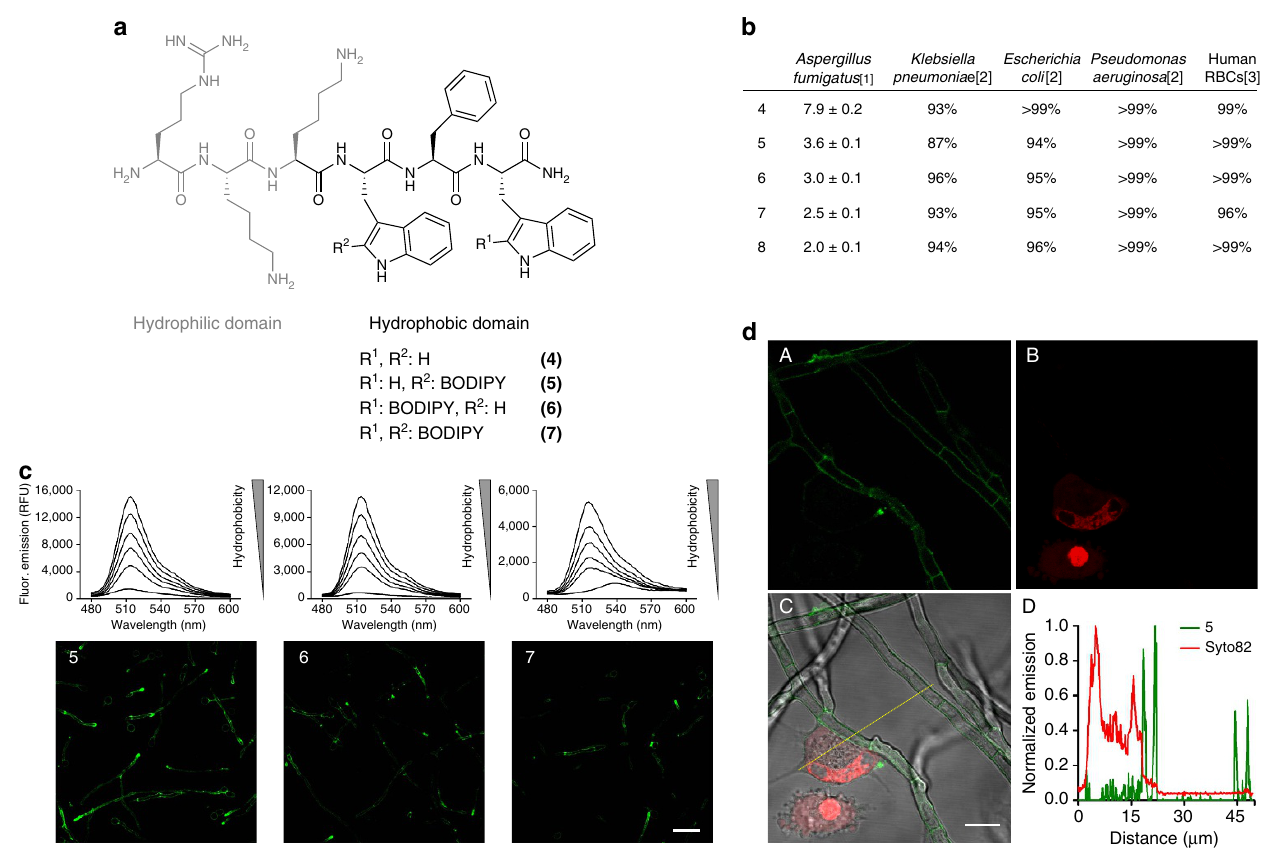
Figure 2 | Fluorogenic peptides for live cell imaging of A.fumigatus in co-culture with human lung epithelial cells. ( a ) Chemical structures of non- labelled and fluorogenic linear peptides ( 4 - 7 ), highlighting the two conserved hydrophilic (grey) and hydrophobic (black) domains of Peptide Antifungal 26 (PAF26). ( b ) Activity of antimicrobial peptides in A. fumigatus , several bacterial strains and in human RBCs.[1] IC 50 ( m M) values represented as means ± s.e.m. from n ¼ 3, [2] cell viability upon 16h incubation with 4 – 8 at their respective IC 50 concentrations ( n ¼ 3), [3] cell viability upon 1h incubation with 4 – 8 at their respective IC 50 concentrations ( n ¼ 3). ( c ) Fluorogenic behaviour of 5 – 7 (10 m M) in phosphatidylcoline (PC):cholesterol (7:1) liposome suspensions in PBS ranging from 3.75 to 0.004mgml (cid:2) 1 of PC in two-fold serial dilutions ( l exc. : 450nm), and wash-free live cell images of A. fumigatus at 37 (cid:2) C using fluorescence confocal microscopy after incubation with peptides 5 – 7 (5 m M). Scale bar, 20 m m. ( d ) Peptide 5 (5 m M, green) and Syto82 (2.5 m M, red counterstain for lung epithelial cells) were incubated in co-cultures of A. fumigatus and human lung A549 epithelial cells and imaged under a fluorescence confocal microscope at 37 (cid:2) C without any washing steps. Fluorescence staining of 5 (A), Syto82 (B), merged (C) and plot profile analysis (D) of peptide 5 (green) and Syto82 (red) from image C. Scale bar, 10 m